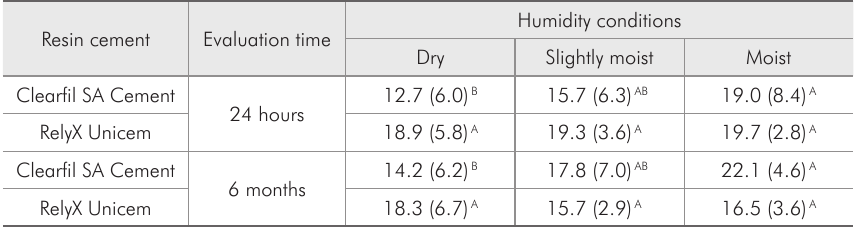
Table 2 - Mean (standard deviation) bond strength (MPa) of resin cements to